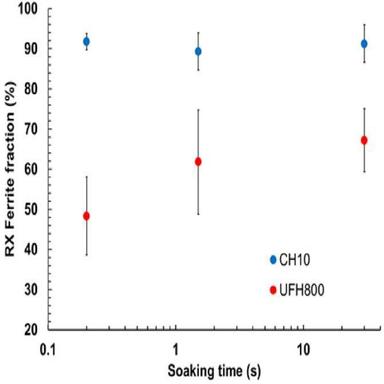
Evolution of volume fraction of recrystallized ferrite with respect to the total fraction of ferrite with heating rate and soaking time.